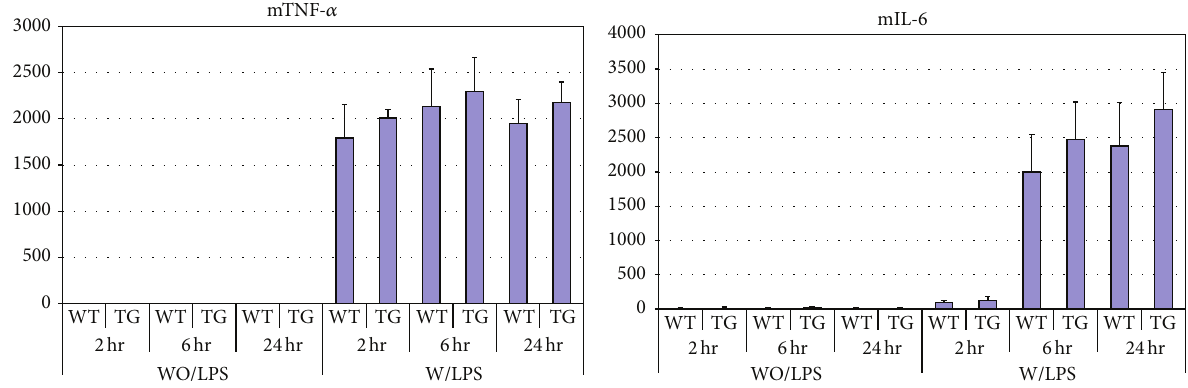
Figure 3: Peritoneal macrophages from WT and 𝑁𝐴𝐺 - 1 𝑇𝑔/𝐿𝑜𝑥 mice show no difference in the production of inflammatory cytokines in response to LPS. Peritoneal macrophages were isolated from WT and 𝑁𝐴𝐺 - 1 𝑇𝑔/𝐿𝑜𝑥 mice after 3 days of thioglycollate injection and plated on 60mm dishes. After 24hrs, cells were treated with LPS (1ng/mL) and culture media were collected at the indicated time points. The levels of TNF- 𝛼 and IL-6 from 3 dishes for each treatment were measured, in duplicate, using cytokine-specific ELISAs (R&D). The mean ± standard deviation is reported.